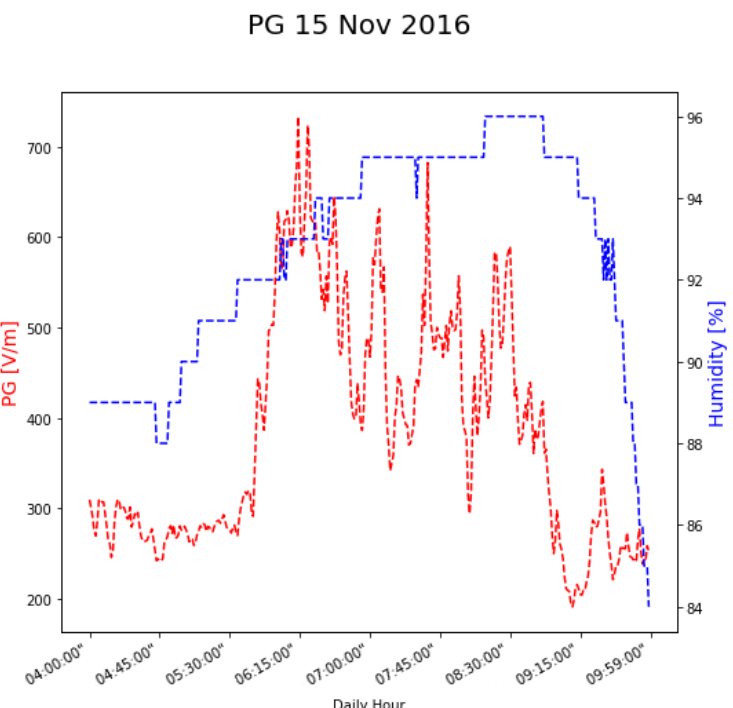
Figure 3. Time dependence of the potential gradient and the relative humidity for the period 04:00–10:00 local time, on 15 November 2016. Note the decrease in PG that precedes the actual dissipation of fog, manifested by the rapid decrease in relative humidity.